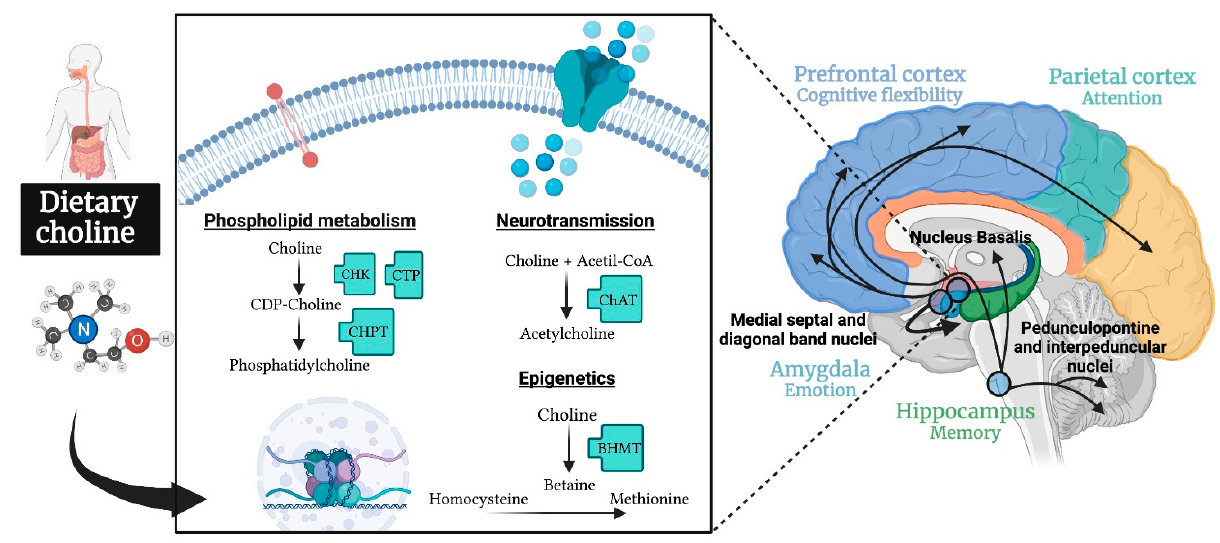
Figure 1. Schematic diagram depicting the biological pathways by which dietary choline supply can influence the brain function related to cognition. Most of the available evidence focuses on the role of choline as a precursor of the widespread neurotransmitter acetylcholine associated with the modulation of brain areas related with attention, memory, behavioral flexibility and emotion. Emerging evidence highlights the potential relevance of its contribution to maintain cell membranes through the phospholipid synthesis and to the epigenetic changes associated with cognition as a methyl donor. Abbreviations: BHMT, betaine homocysteine-methyltransferase; CDP-choline, cytidine 5’-diphosphocholine; ChAT, choline acetyltransferase; CHK, choline kinase; CHPT cholinephosphotransferase; CTP, phosphocholine cytidylyltransferase. Created with BioRender.com.